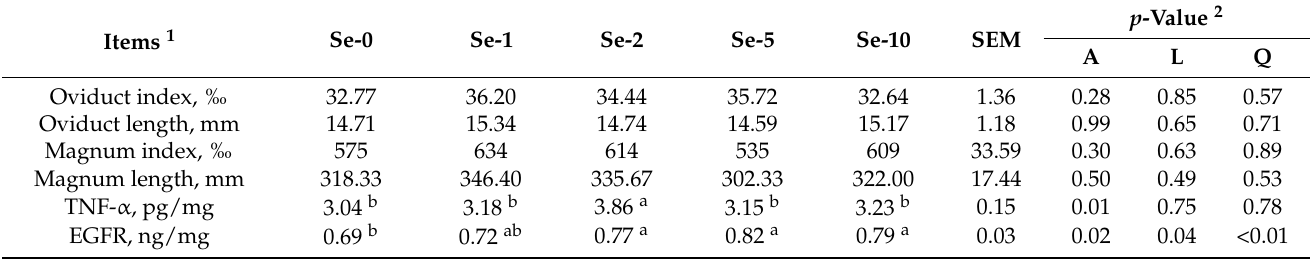
Table 10. Effects of dietary organic selenium on oviduct health of laying hens.